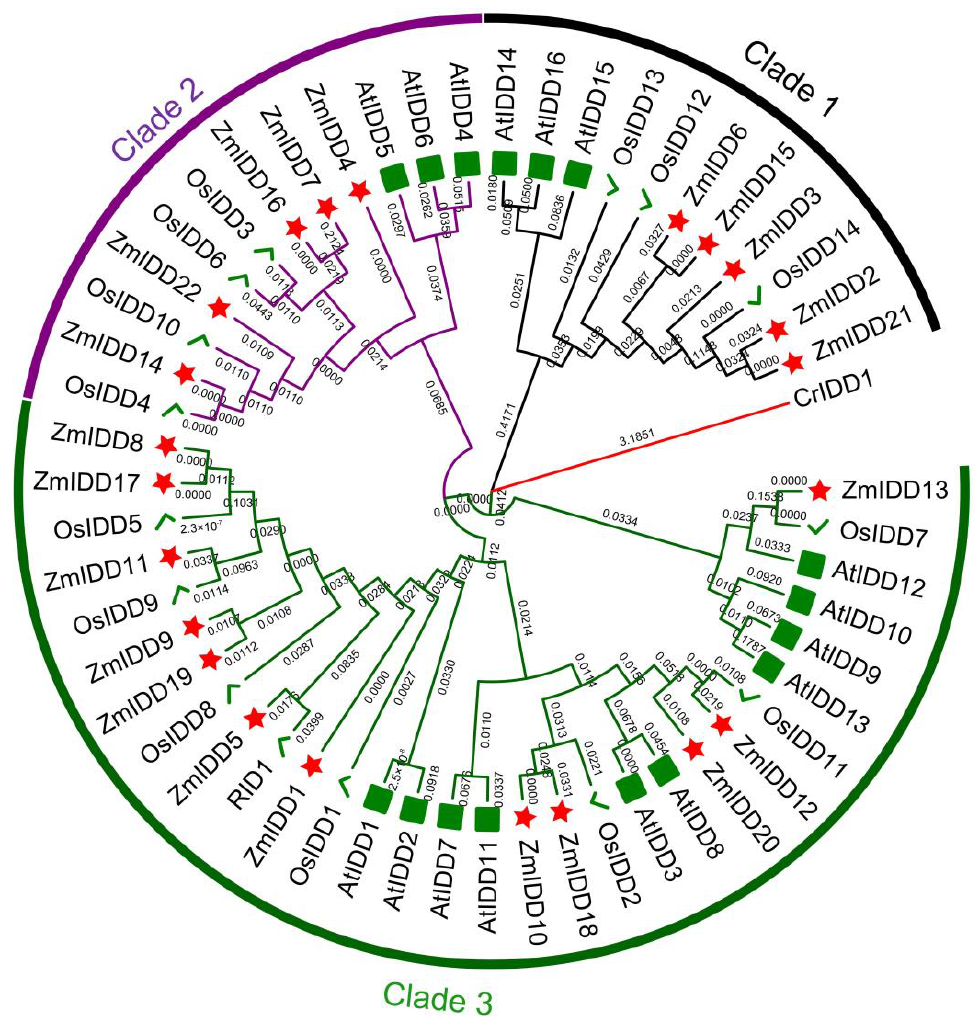
Figure 1. Phylogenetic tree of full-length ZmIDD, AtIDD, and OsIDD proteins using the Maximum Likelihood method based on the JTT matrix-based model. The tree is drawn to scale, with branch lengths measured in the number of substitutions per site. The analysis involved 54 amino acid sequences. All positions containing gaps and missing data were eliminated. There were a total of 94 positions in the final dataset. The different colored arcs indicate subfamilies of the IDD proteins. Different colored shapes represent IDDs from maize ( ☆ ), rice (√), and Arabidopsis ( ). IDD in Chla- mydomonas reinhardtii was selected as an outgroup.